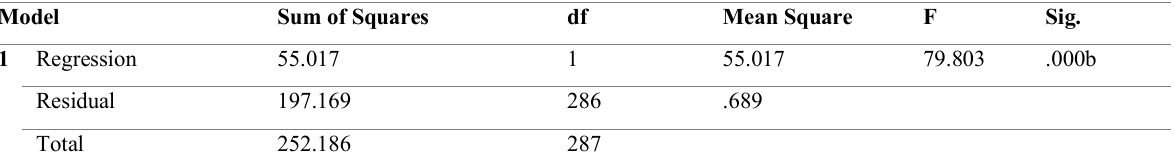
Table 3: ANOVA for regression of LD against